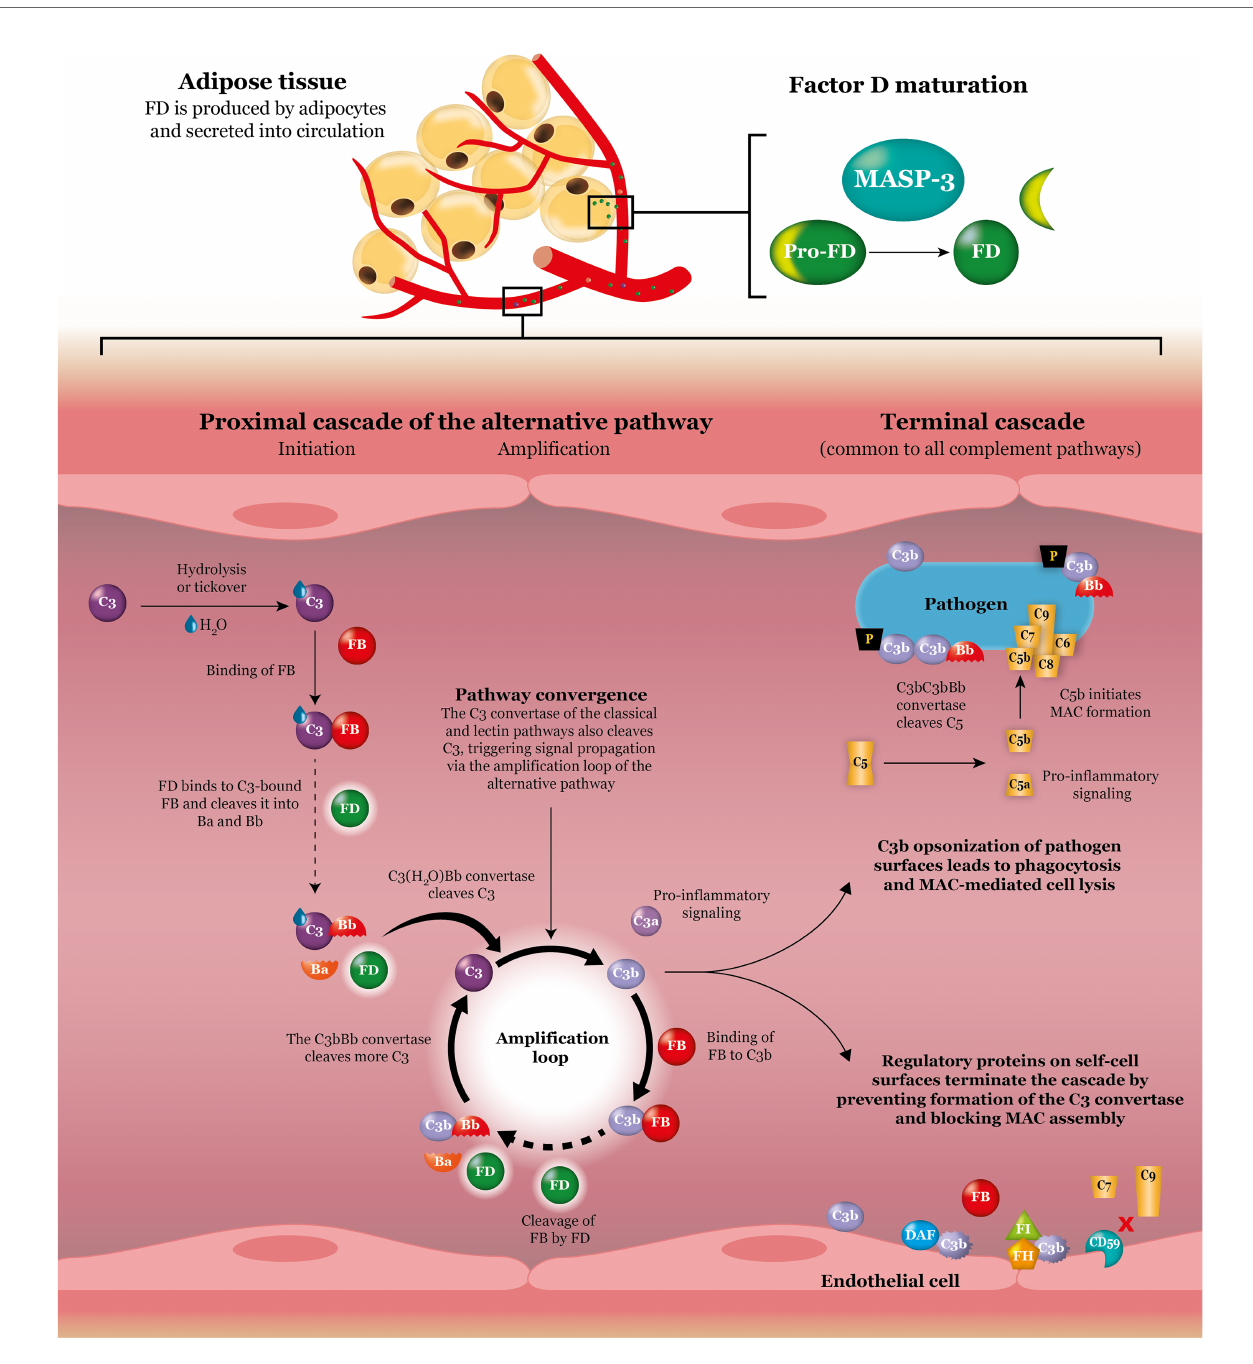
FIGURE 1 | Factor D in the alternative complement pathway. Factor D is produced by adipocytes and secreted into circulation. Once MASP-3 has cleaved off the propeptide and converted factor D into its mature form, factor D is ready to perform its essential function in both the initiation phase and the ampli fi cation phase of the alternative complement pathway. First, factor D cleavage of C3-bound factor B is responsible for generation of the C3(H 2 O)Bb convertase, which splits C3 into C3b and the pro-in fl ammatory signaling anaphylatoxin C3a. Second, factor D cleavage of C3b-bound factor B in the ampli fi cation loop is responsible for generation of the predominant C3 convertase C3bBb, which ampli fi es the signal and creates additional C3b and C3a molecules. The classical and lectin complement pathways converge at the ampli fi cation loop of the alternative pathway and as such their signals are also ampli fi ed by the action of factor D. Besides incorporation into C3 convertase complexes for signal ampli fi cation, C3b also functions to opsonize cells for phagocytosis and, via downstream reactions, initiates MAC formation and cell lysis. Inhibition of these activities on self-cell surfaces is controlled by a network of regulatory proteins. Dashed arrows represent the rate-limiting steps. C, complement; DAF, decay-accelerating factor; FB, factor B; FD, factor D; FH, factor H; FI, factor I; MAC, membrane attack complex; P,